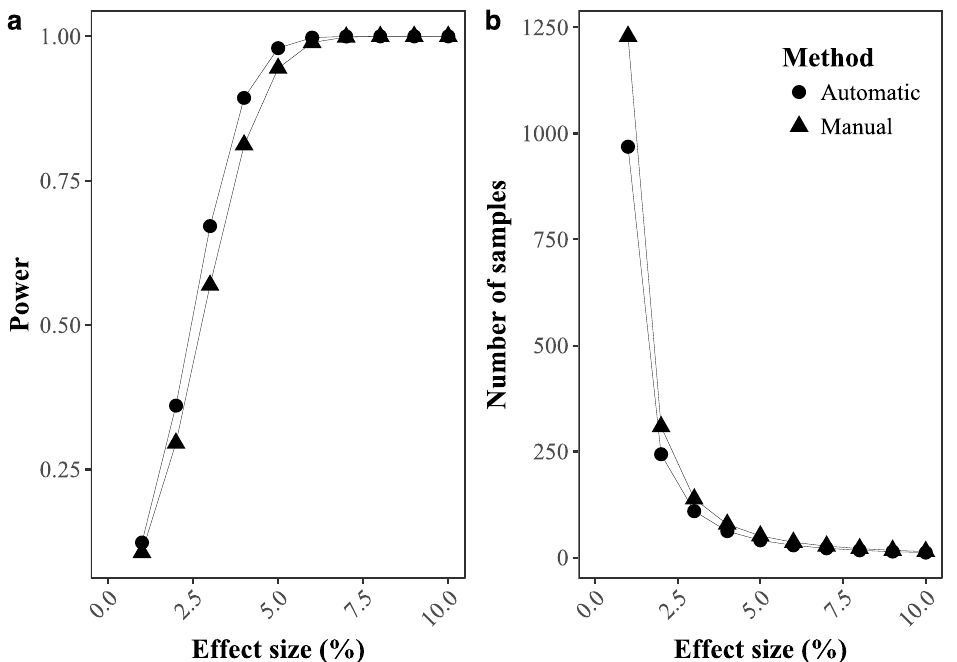
Figure 6. Power analysis for the detection of temporal change between manual (circle) and automatic image annotation (triangle). ( a ) Using a paired t -test analysis for evaluating change, the power of the test was calculated at different size effects. ( b ) Using a fixed power (0.8), the number of samples required to achieve such power at different effect sizes was estimated for each method.